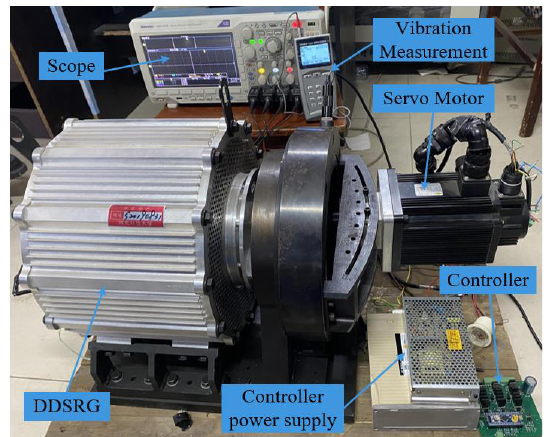
Figure 20. DDSRG experimental platform.